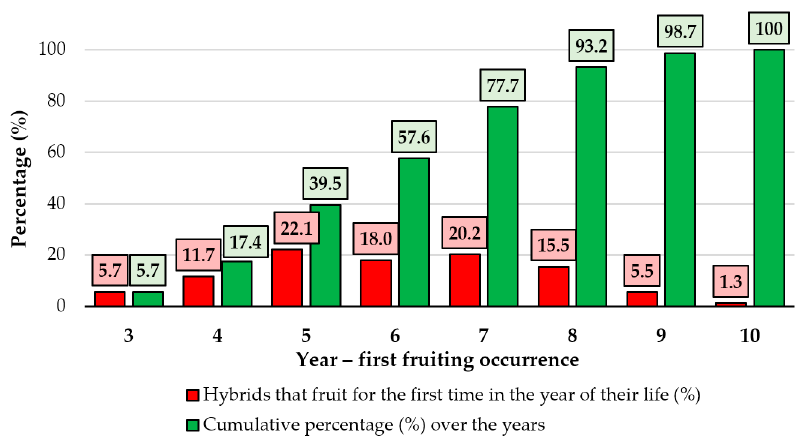
Figure 2. The length of the juvenile period in the F 1 apple hybrids in the experiment expressed by the year of the first fruiting and the cumulative percentage over the years.